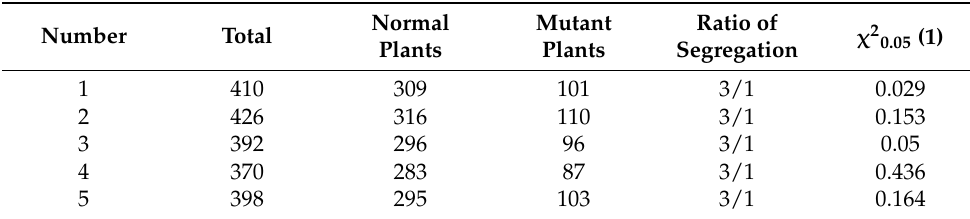
Table 1. Segregation of leaf color in the F 2 population.